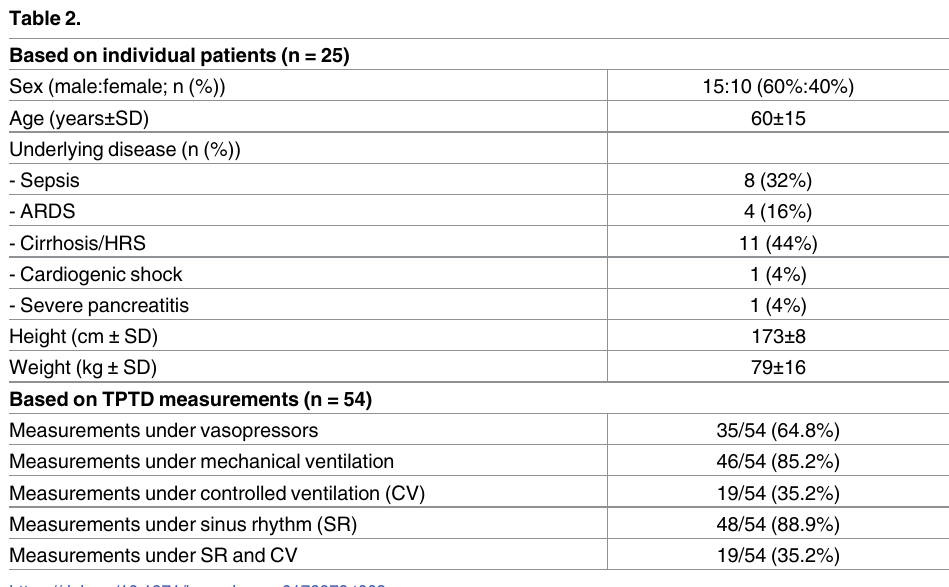
Comparison of PVPI-measurements using different indicator injection sites (all measurements)